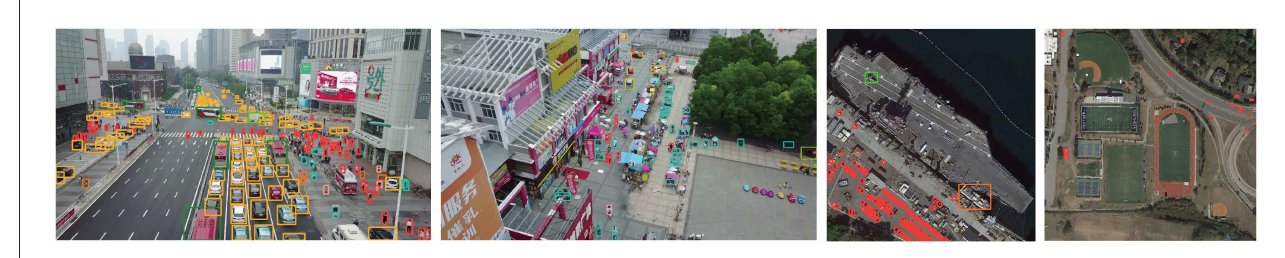
FIGURE1 Examples of targets in remote sensing